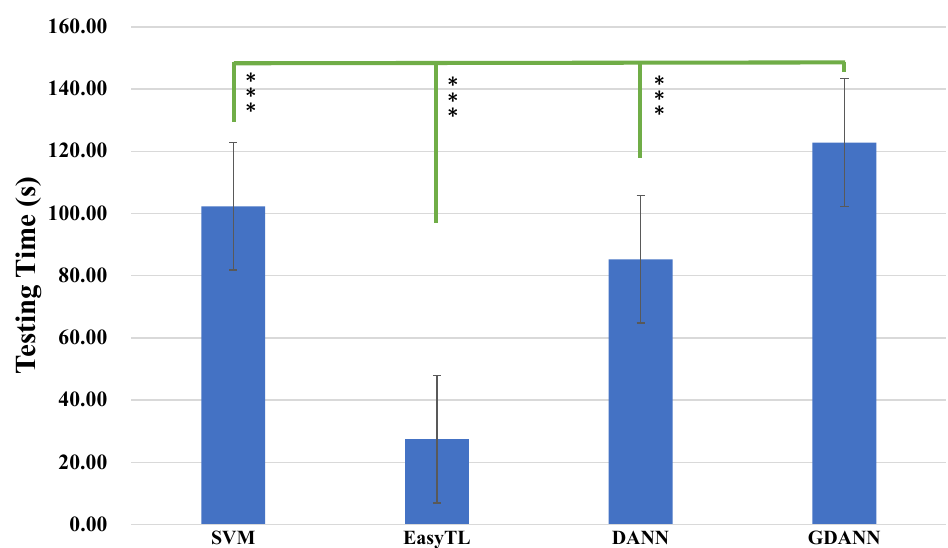
Figure 12. Testing time comparison between SVM, EasyTL, DANN and GDANN. (The testing time is the total time for one target subject to train the model and test results with the trained classifier, ∗∗∗ indicates p <